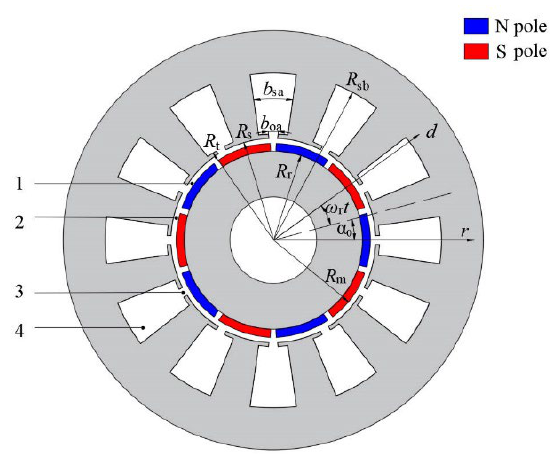
Figure 1. Machine model and four types of subdomains.